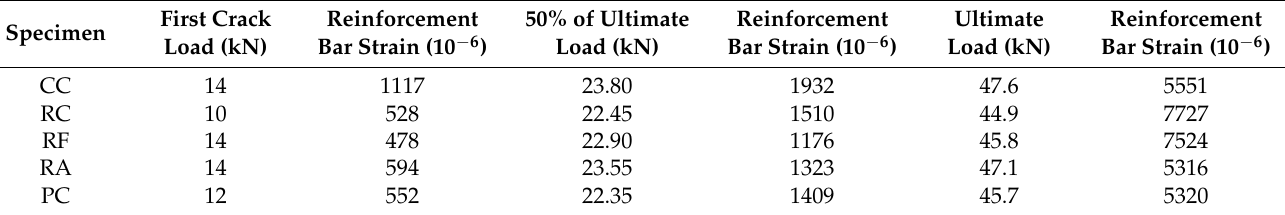
Figure 6. Load–strain curve of the reinforcement bars used in beams ( a ) RC ( b ) RF ( c ) RA ( d ) PC. Table 7. Tensile strain of the reinforcement bars and ultimate loads.